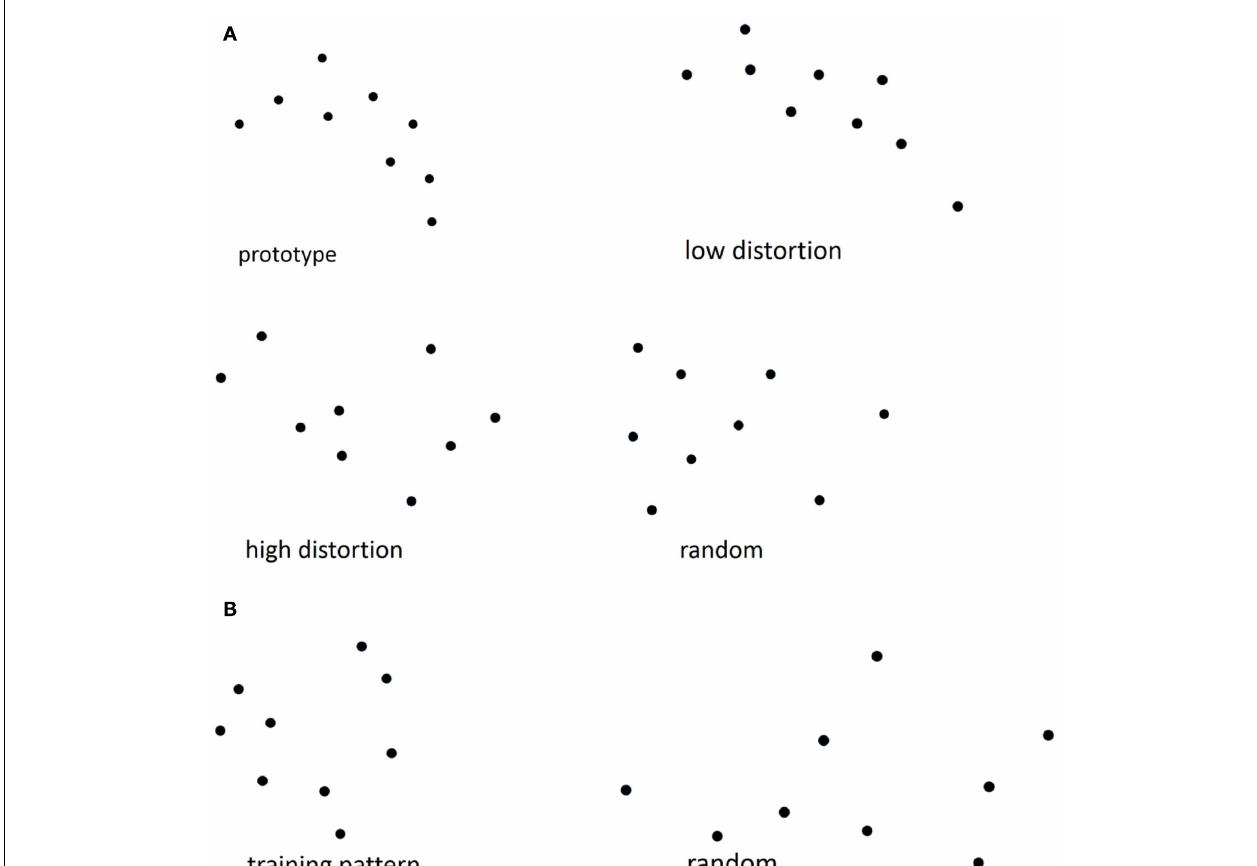
FIGURE 1 | (A) Examples of prototype, high, low distortion, and random dot patterns from the dot-pattern judgment test, (B) examples of training and random patterns from the dot-pattern recognition test.